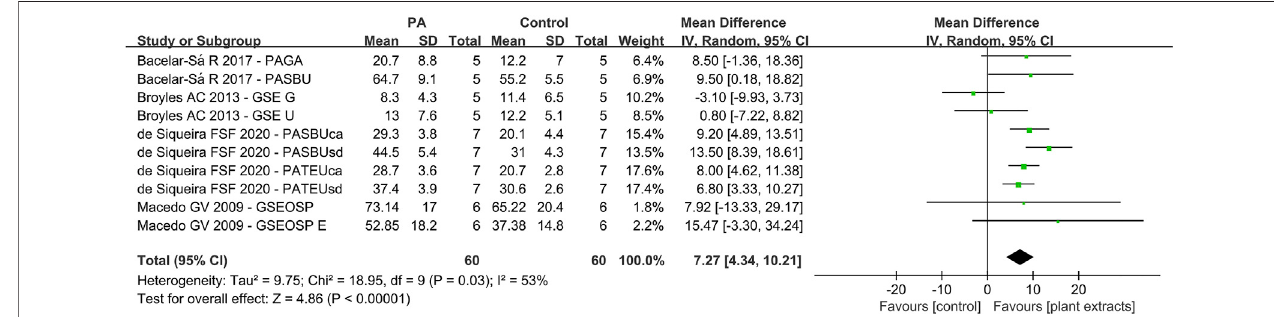
FIGURE 4 | Forest Plot — plant extract primers: self-etch immediate bond strength.